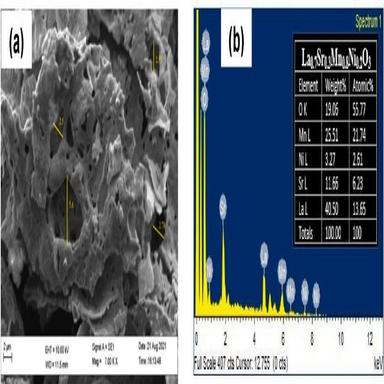
(a) Scanning electron microscope (SEM) of LSMN7382 nanopowder and (b) corresponding Elemental analysis (EDAX).